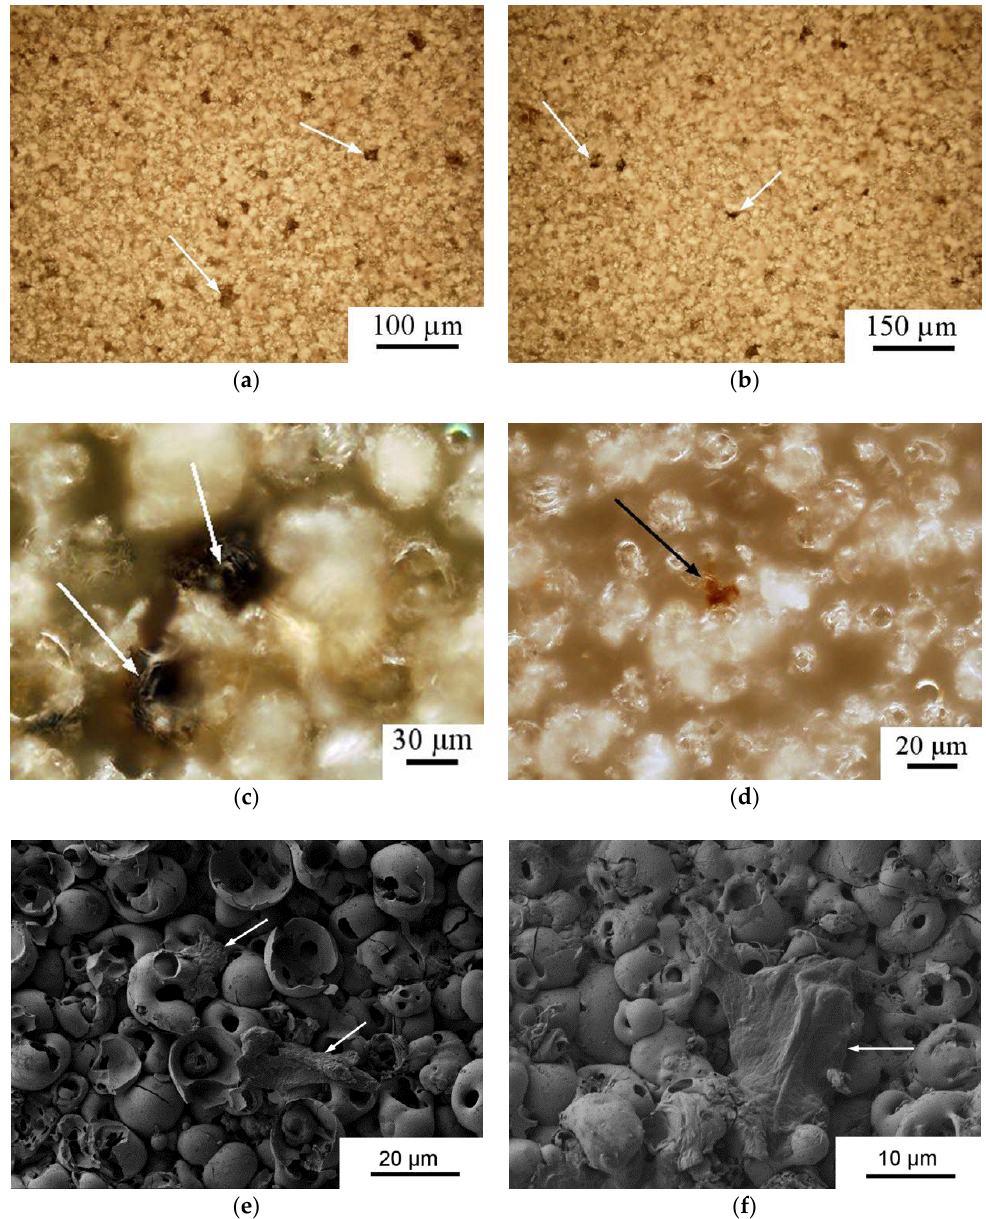
Figure 9. Surface distribution ( a , b ) and typical locations of alkaline phosphatase (ALP)- ( a , c ) or osteocalcin (OCN)-stained ( b , d ) HLPSCs (brown sites) in the sockets of the microarc-fabricated rough CP coating (reflecting optical microscopy) and SEM images of the HLPSCs ( e , f ). Cells are indicated with white and black arrows.